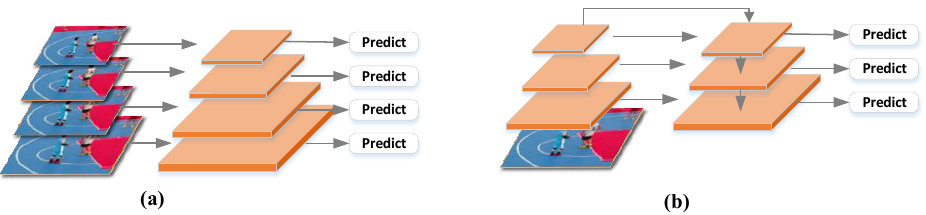
Figure 2. Two kinds of pyramid method for handling multi-scale problem in object detection. ( a ) Image Pyramid uses multi-scale images for prediction. ( b ) Feature Pyramid uses different levels in the feature extraction process for